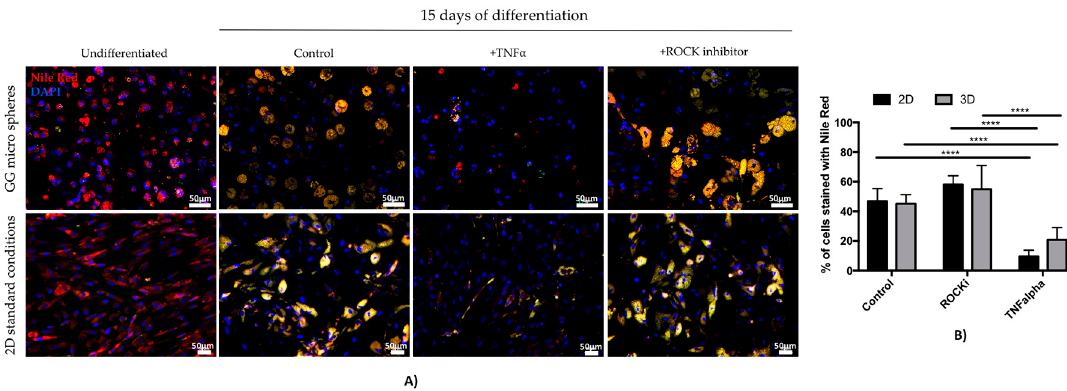
Figure 6. Assessment of the influence of TNF α (0.5 µg/mL) and ROCK inhibitor (50 µM) over the adipogenic differentiation of human adipose-derived stem cells within 0.5% gellan gum hydrogel particles after 15 days of culture in induction medium. ( A ) Representative images of nile red staining (polar cell membrane lipids are stained in red), and respective ( B ) quantification of the percentage of stained cells in relation to the total number of cells. Scale bar 50 µm. **** p < 0.0001.